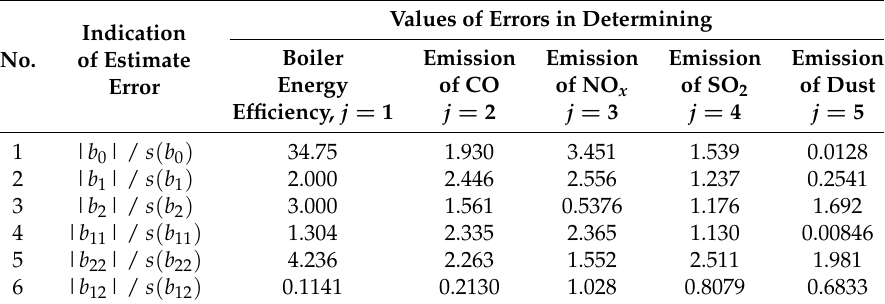
Table 5. Estimation of structural parameters relative to the error of estimation of the